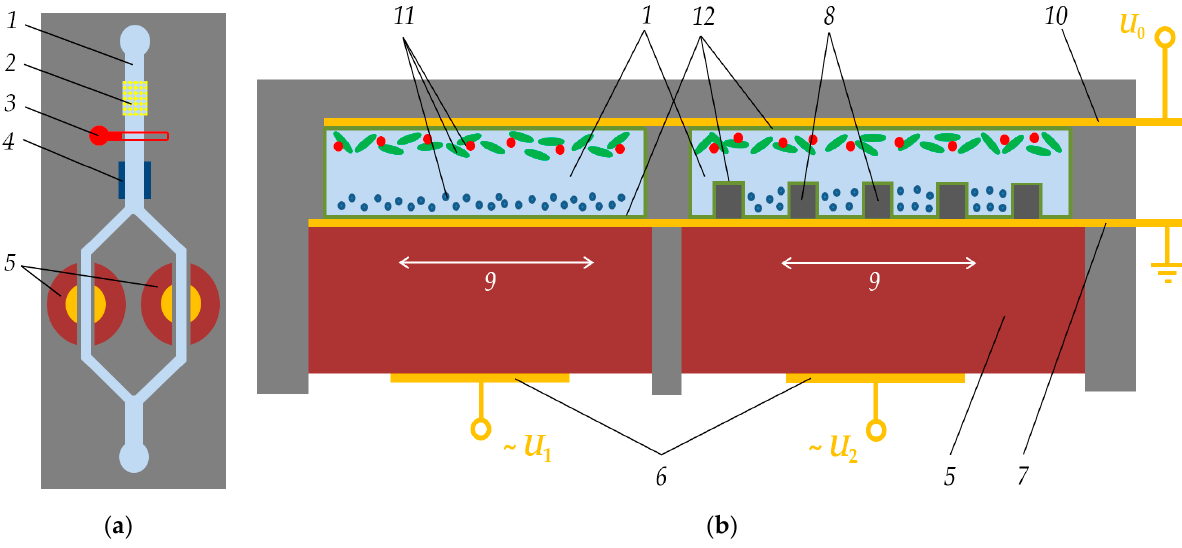
Figure 1. Top ( a ) and slice ( b ) view of a schematic model of the device for manipulating and detecting proteins: 1 —Biological liquid (urine) in the canal; 2 —filter; 3 —temperature control; 4 — pH control; 5 —piezoelectric quartz crystal resonators; 6 —bottom electrodes under alternating probing potential U 1 and U 2 ; 7—top grounded electrode; 8 —set of protrusions placed on the top electrode surface; 9 —direction of shear vibrations of a quartz resonator, perpendicular to the microfluidic channels and a set of top electrode protrusions; 10 —addition electrode over the channel for particles manipulations in liquid due to the application of electric potential U 0 ; 11 —different types of protein particles; and 12 —surface passivation layer. Geometrical proportions of the figures are not observed for reasons of visual clarity (e.g. quartz crystal must be much thicker; many tens of periods of protrusions must fit on the area of the top electrode; parti- cles must be smaller in reality).